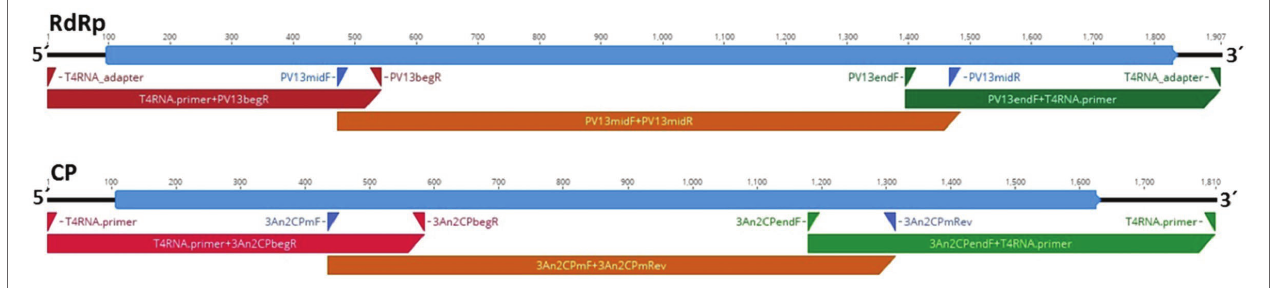
FIGURE 2 | Schematic presentation of the genome organization of HetPV13-an1 (94233-RC3) showing the predicted coding regions for the RNA-dependent RNA polymerase (RdRp) and CP (blue) and the location of primers and corresponding amplification products (red, brown, and green) used for genome sequence determination.